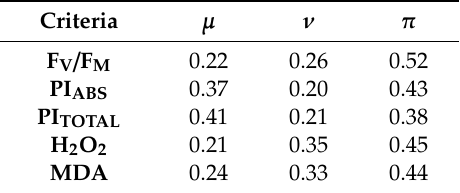
Table 12. Weighted aggregated IF decision matrix for criteria of drought